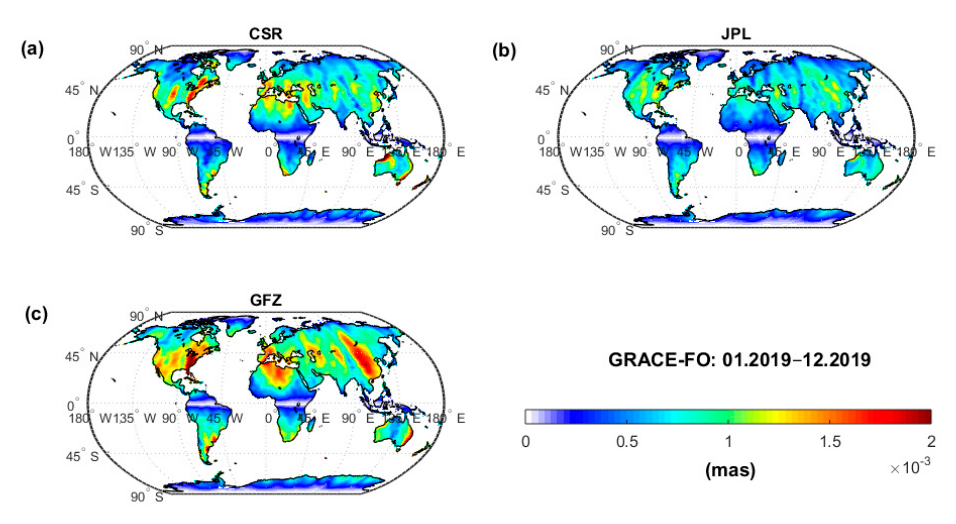
Figure 4. Maps of RMS of differences between the mean GRACE solution (mean of data from CSR, JPL, and GFZ) and ( a ) HAM/CAM from CSR, ( b ) HAM/CAM from JPL, and (c) HAM/CAM from GFZ for 2006 (the period of best GRACE performance). The values are given in mas.